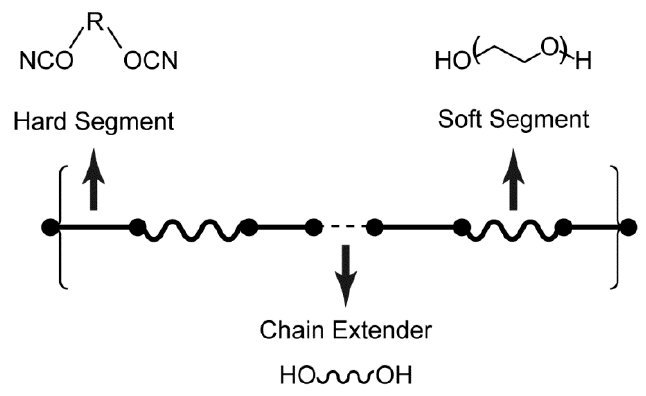
Figure 1. General chemical structure of polyurethanes.